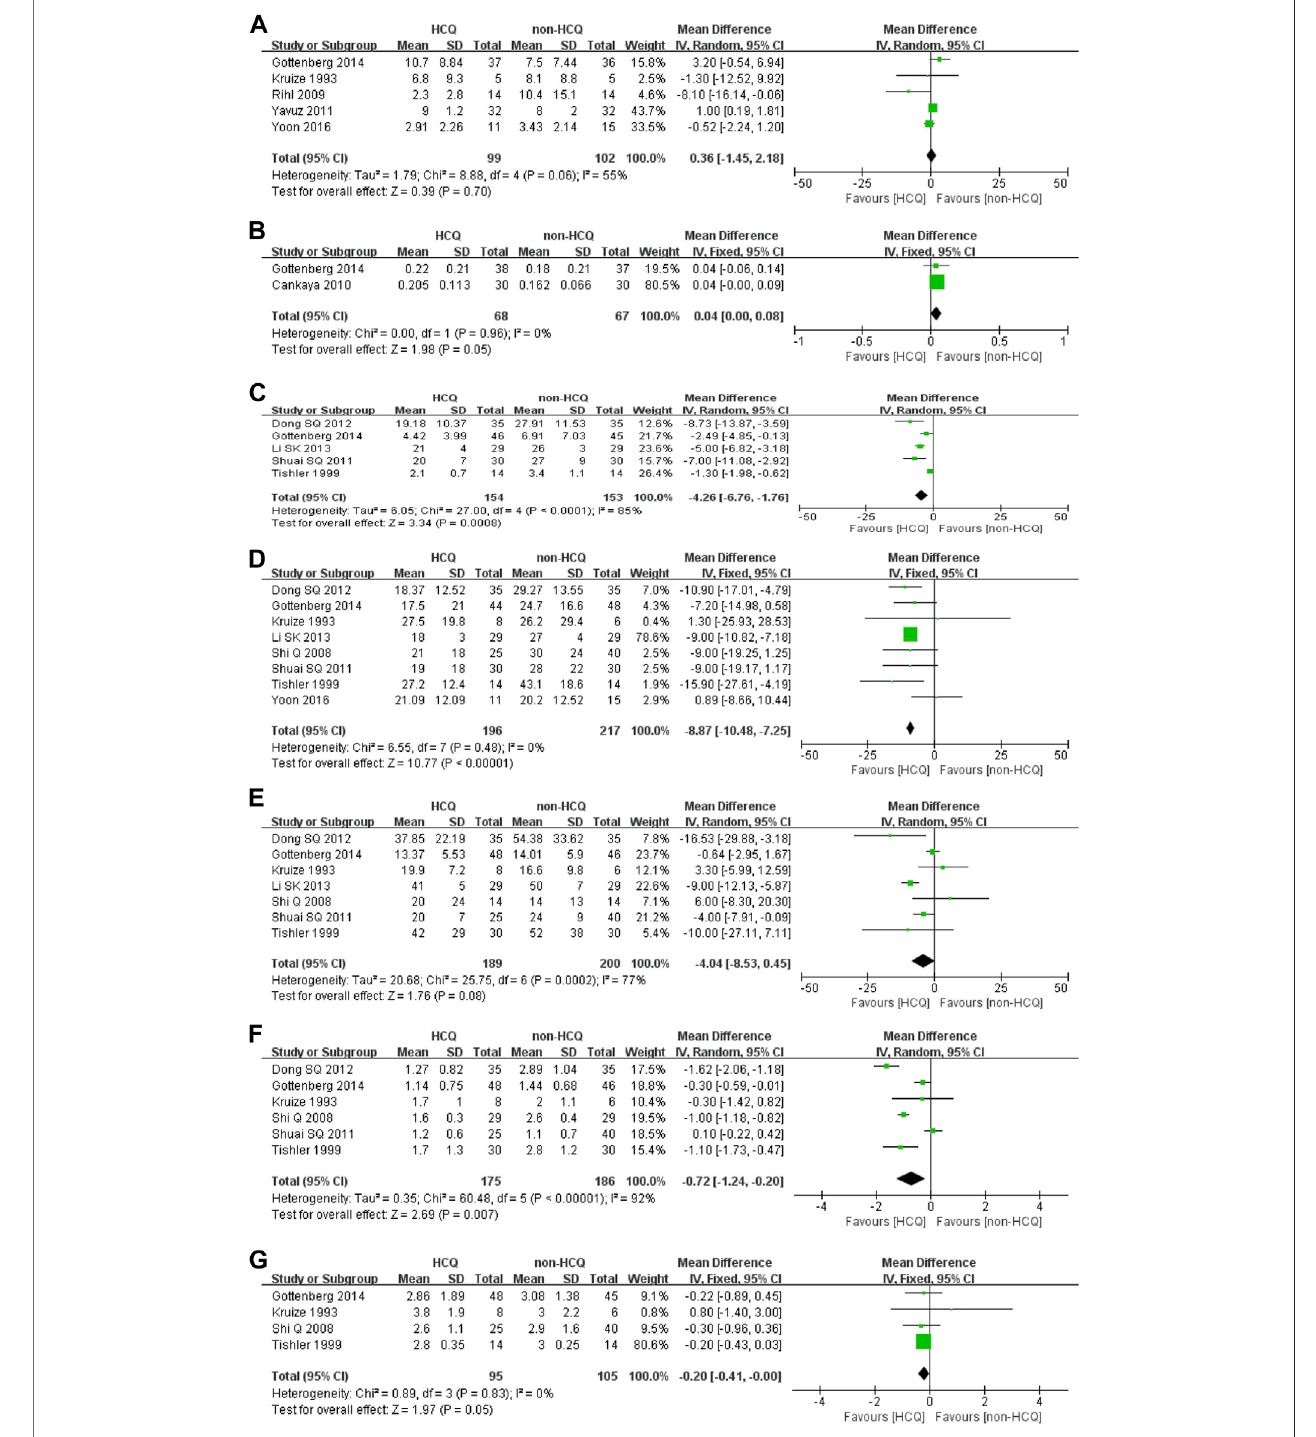
FIGURE 4 | Forest plot of studies comparing HCQ group and the non-HCQ group, examining the effect on pSS (including Schirmer ’ s test, uSFR, CRP, ESR, IgG, IgM and IgA). (A) Schirmer ’ s test. (B) uSFR. (C) CRP. (D) ESR. (E) IgG. (F) IgM. (G) IgA.